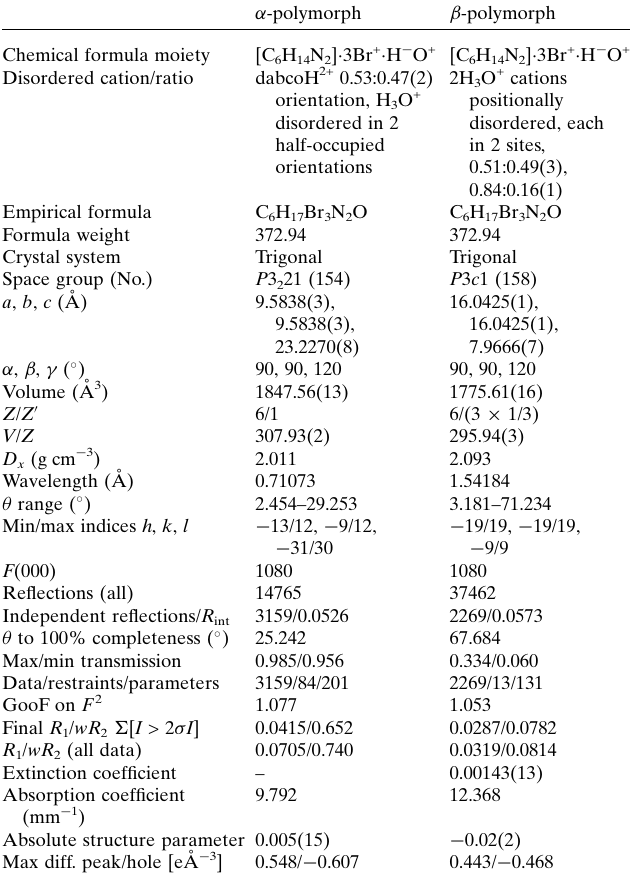
Table 1 Crystal data and experimental details for [dabcoH 2 ] 2+ [H 3 O] + Br (cid:2) 3 poly- morphs (cid:2) and (cid:3) determined at 297 K and 0.1 MPa. Note the different rates of disorder of independent hydronium cations in polymorph (cid:3)